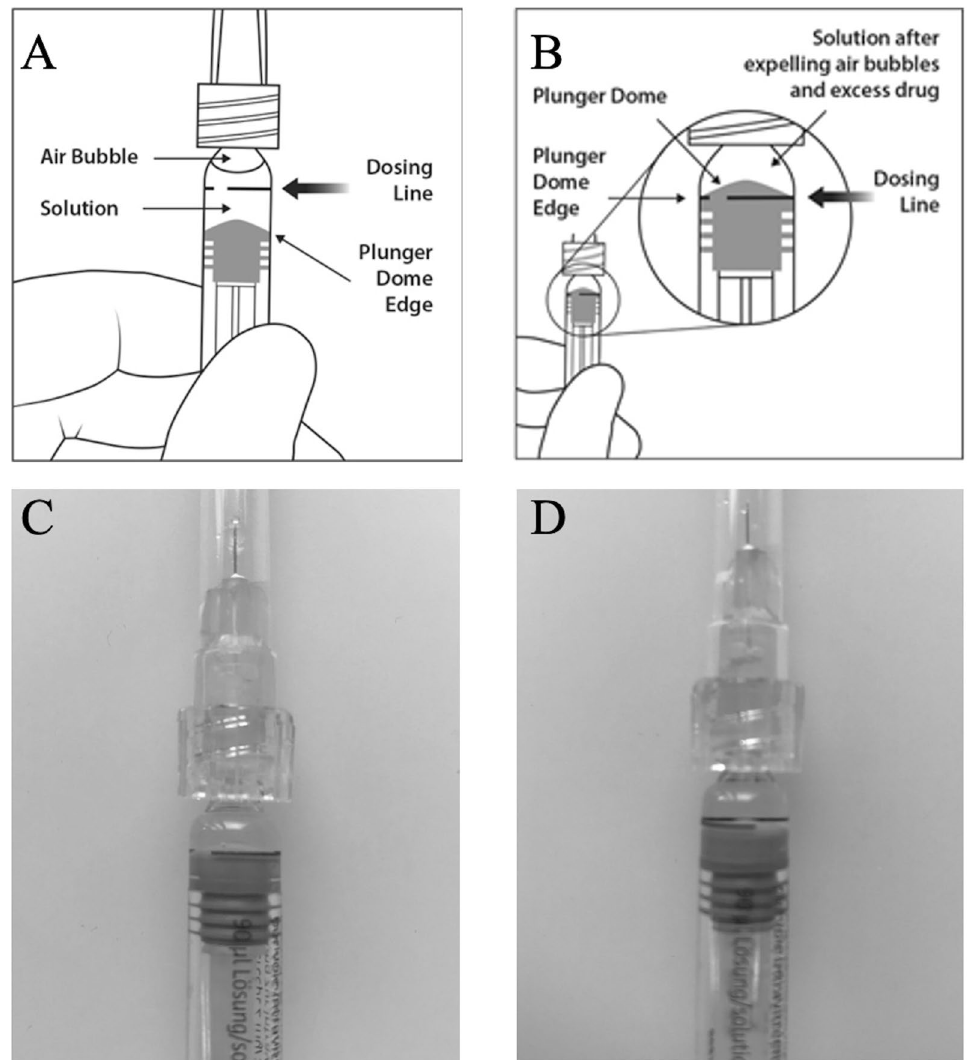
Figure 1. Injection technique with the aflibercept prefilled syringe (PFS). ( A ) Instructions for depressing the plunger rod to align the cylindrical base of the plunger dome edge with the black dosing line on the PFS. ( B ) and ( C ) Correct alignment of the plunger rod. ( D ) Incorrect alignment with the cylindrical base slightly beneath the dosing line. In a daily routine, perfect alignment may not always be achieved (Images A and B are taken from the manufacturer’s guideline: Eylea SmPC, © Bayer (Switzerland)